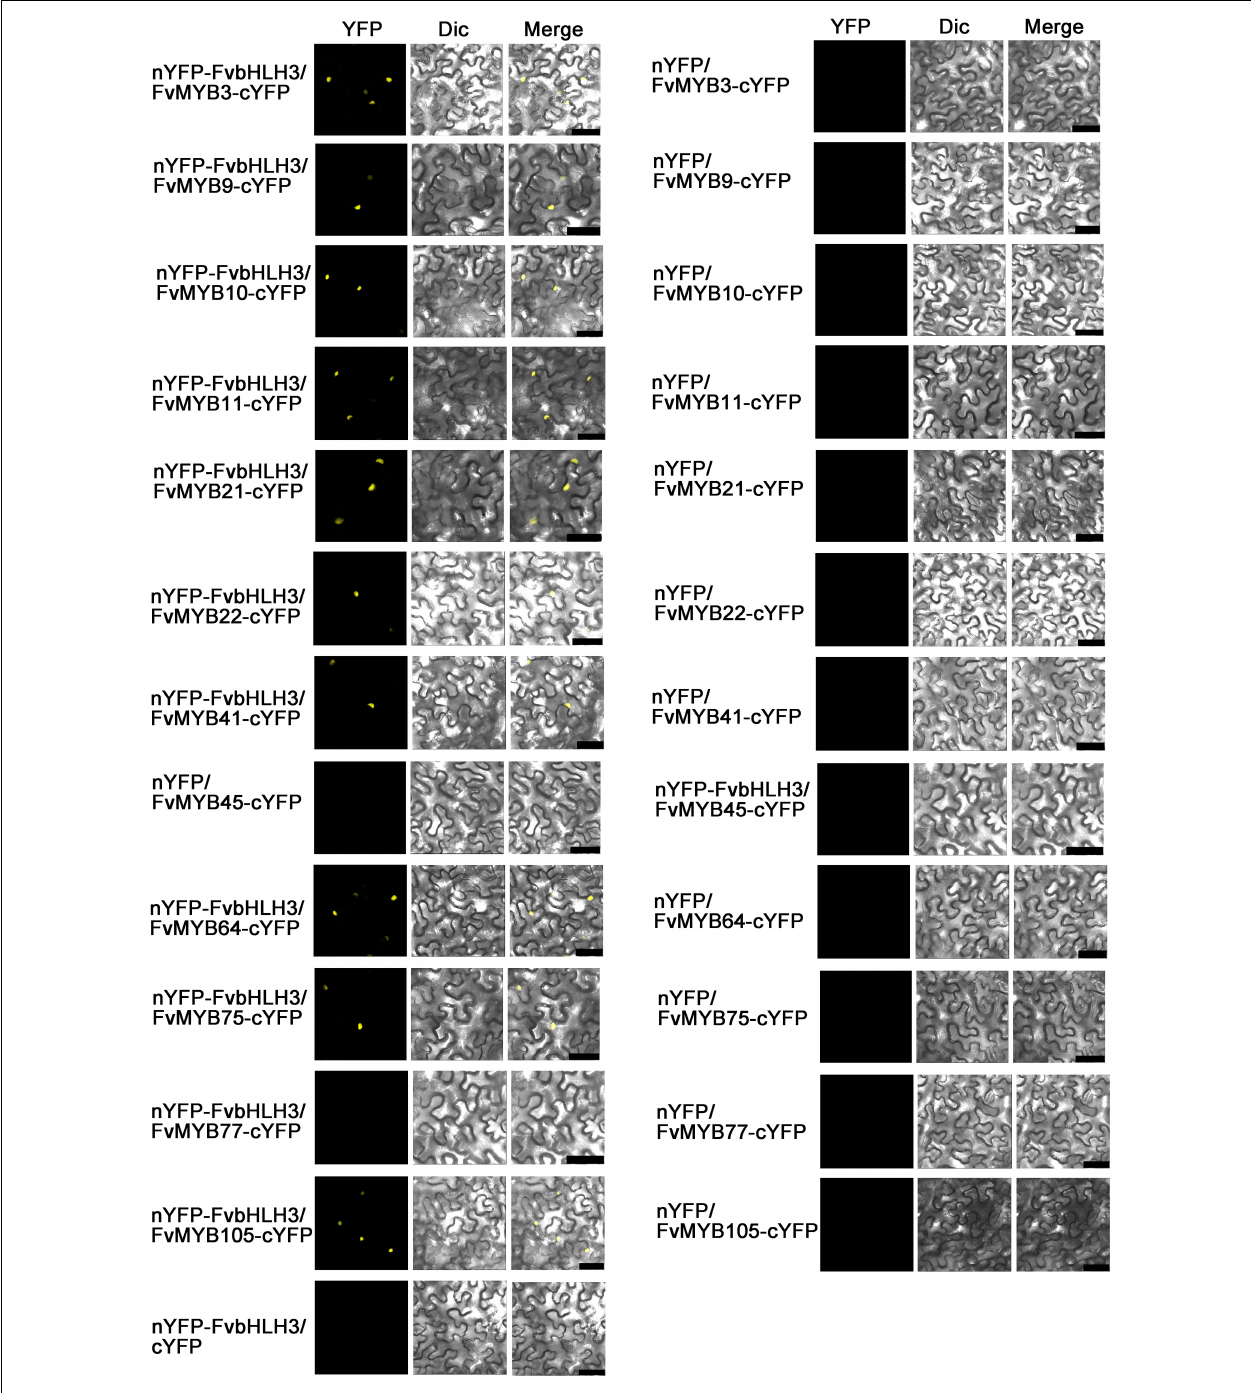
FIGURE 5 | BiFC assay showing interactions between FvMYB proteins and FvbHLH proteins in tobacco cells. Combinations of constructs encoding the indicated proteins were co-transformed into tobacco leaf epidermal cells. Overlays of fluorescence and bright field were shown. Dic, differential interference contrast. Bars, 50 µ